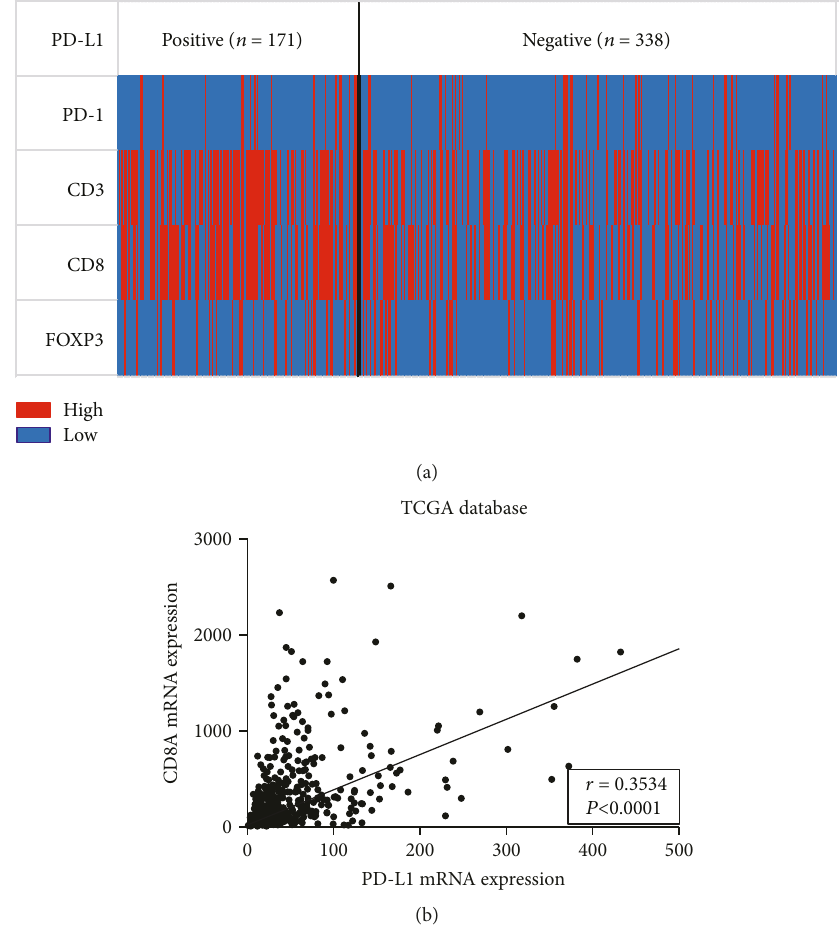
Figure 3: The relationship between PD-L1 expression and T cell in fi ltration in 509 AGC patients and TCGA database. (a) The heat map of PD-1, CD3, CD8, and FOXP3 high and low in fi ltration in tumors of PD-L1-positive and -negative AGC patients. (b) The correlation between PD-L1 and CD8A mRNA expression levels in GC patients in the TCGA